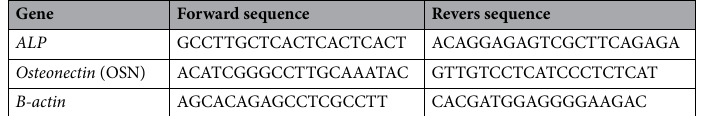
Table 2. Oligonucleotide primers for quantitative real-time PCR